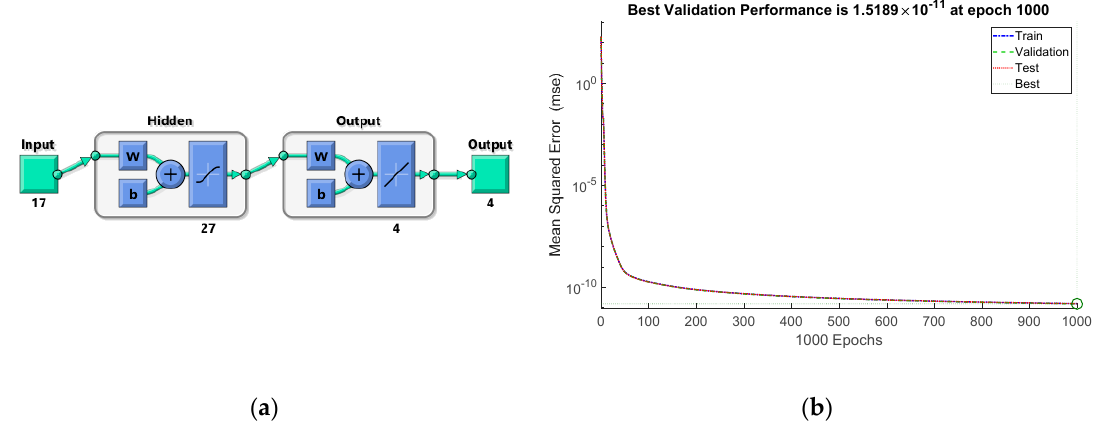
Figure 12. ANN obtained in example 2: ( a ) architecture, ( b ) performance of training.